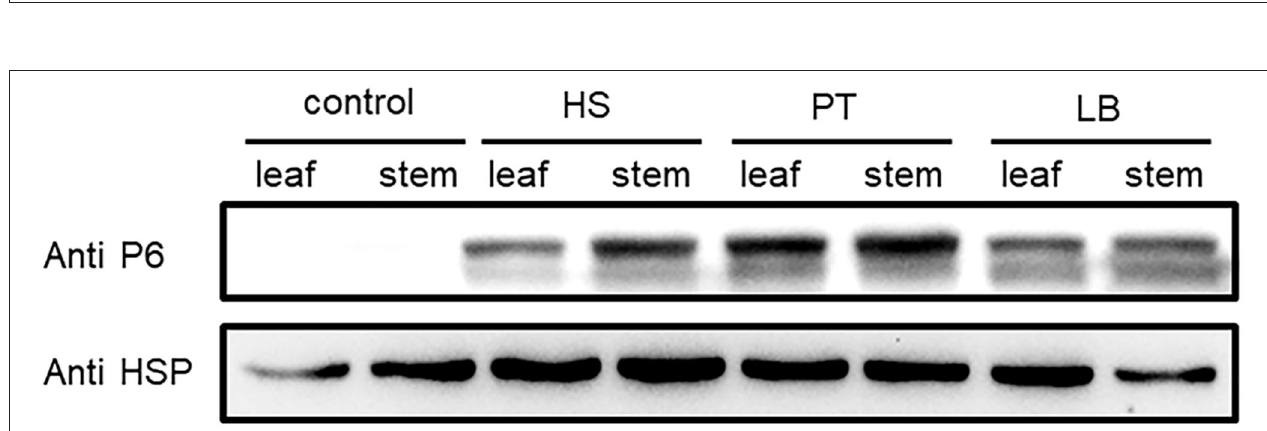
FIGURE 6 | Comparison of SRBSDV content in rice tissues. Rice leaves and stems from Huishui (HS), Pingtang (PT), and Libo (LB) were used to evaluate SRBSDV content. Healthy rice was used as a negative control, and rice internal control HSP90 was used as the internal control.